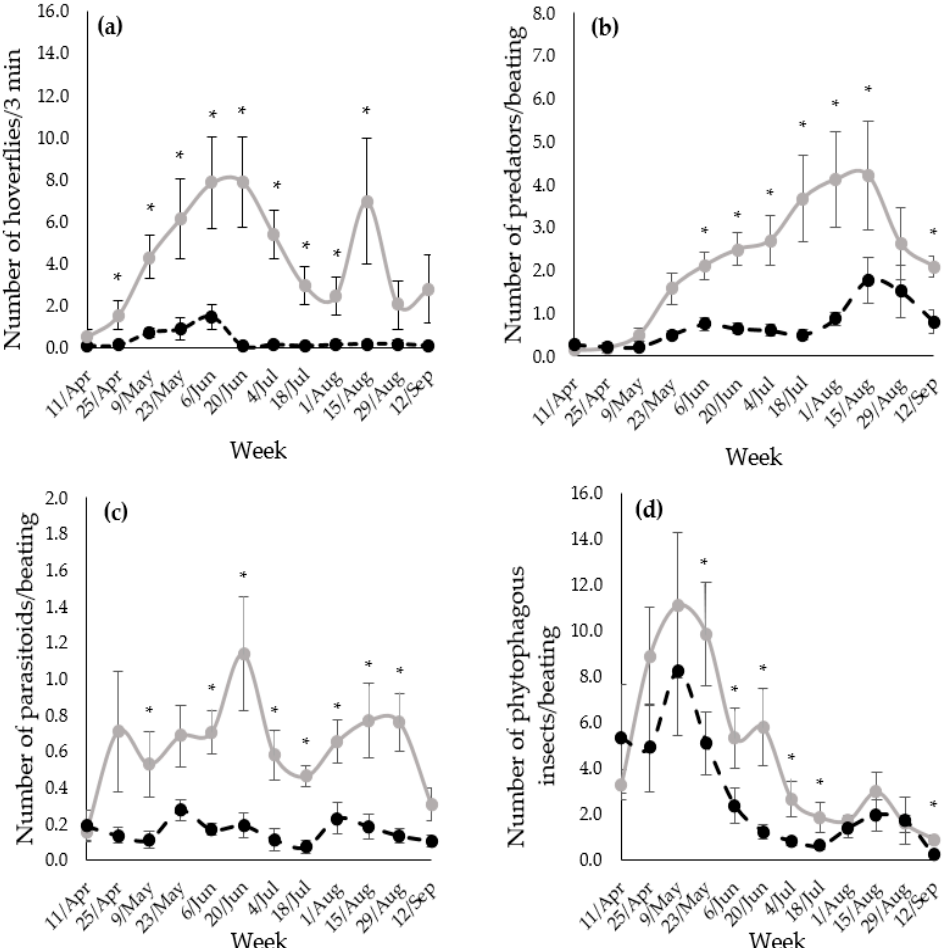
Figure 2. ( a ) Number of adult hoverflies per three minutes, ( b ) number of predators per beating, ( c ) number of parasitoid wasps per beating, and ( d ) number of phytophagous insects per beating in the flower margin (grey line) and in the spontaneous margin (black dashed line). Vertical bars show standard error. Data presented as average of 2015 and 2016 per week in 1 m 2 . ns = p > 0.05, * = p < 0.05.